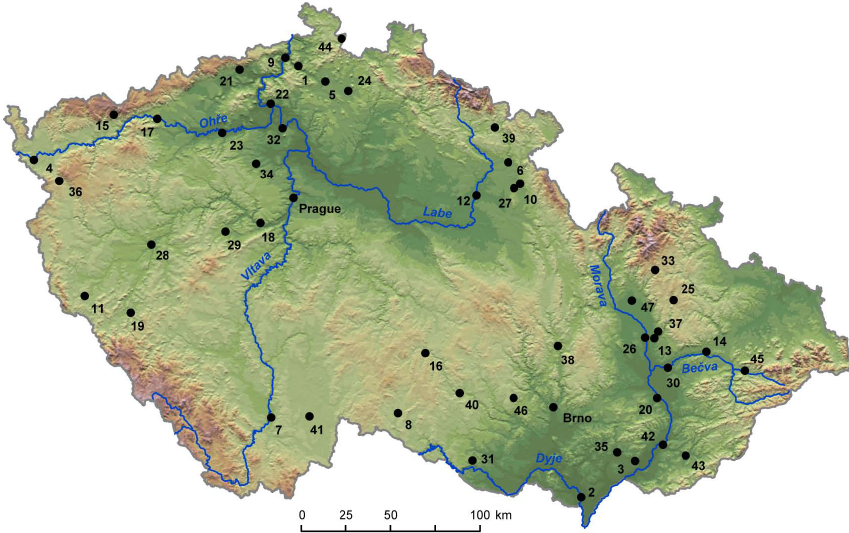
Fig. 1. Locations and rivers in the Czech Republic mentioned in this paper: 1 – Beneˇsov nad Plouˇcnic´ı, 2 – Bˇreclav, 3 – Bzenec, 4 –